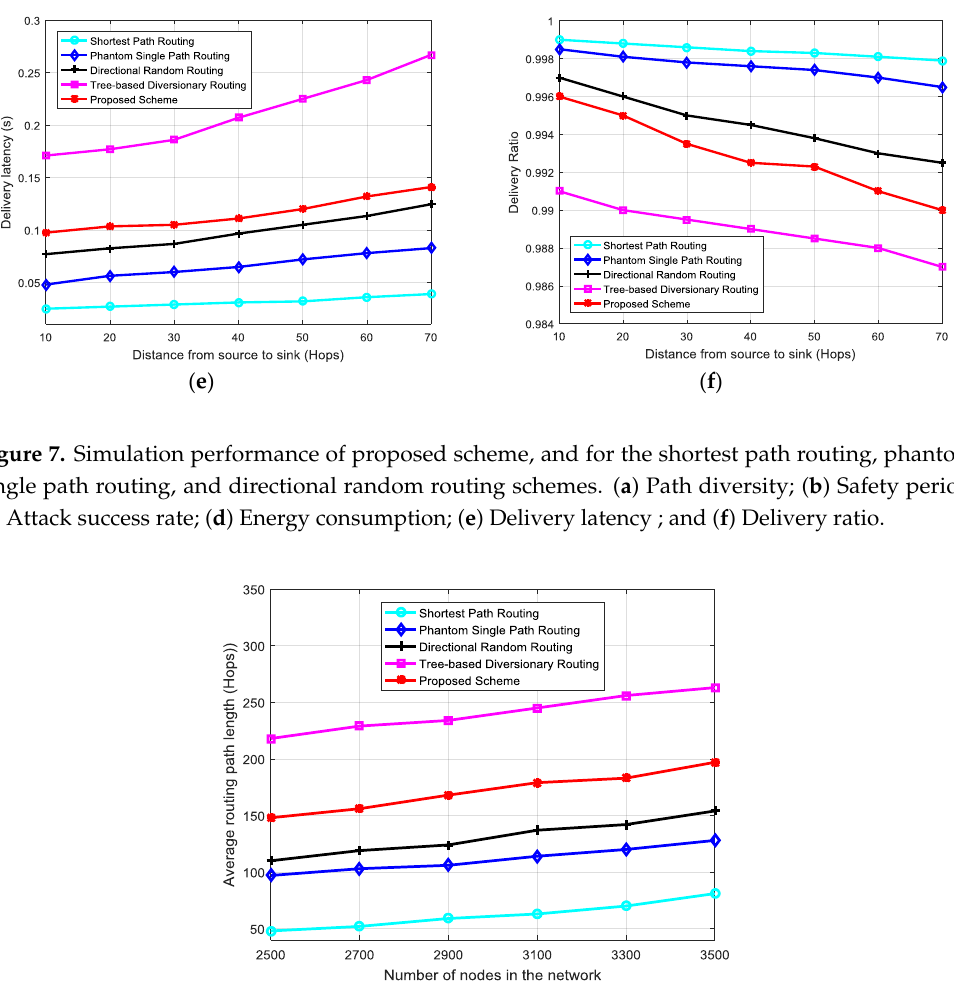
Figure 8. Variation of routing path length as node density increases in the network.